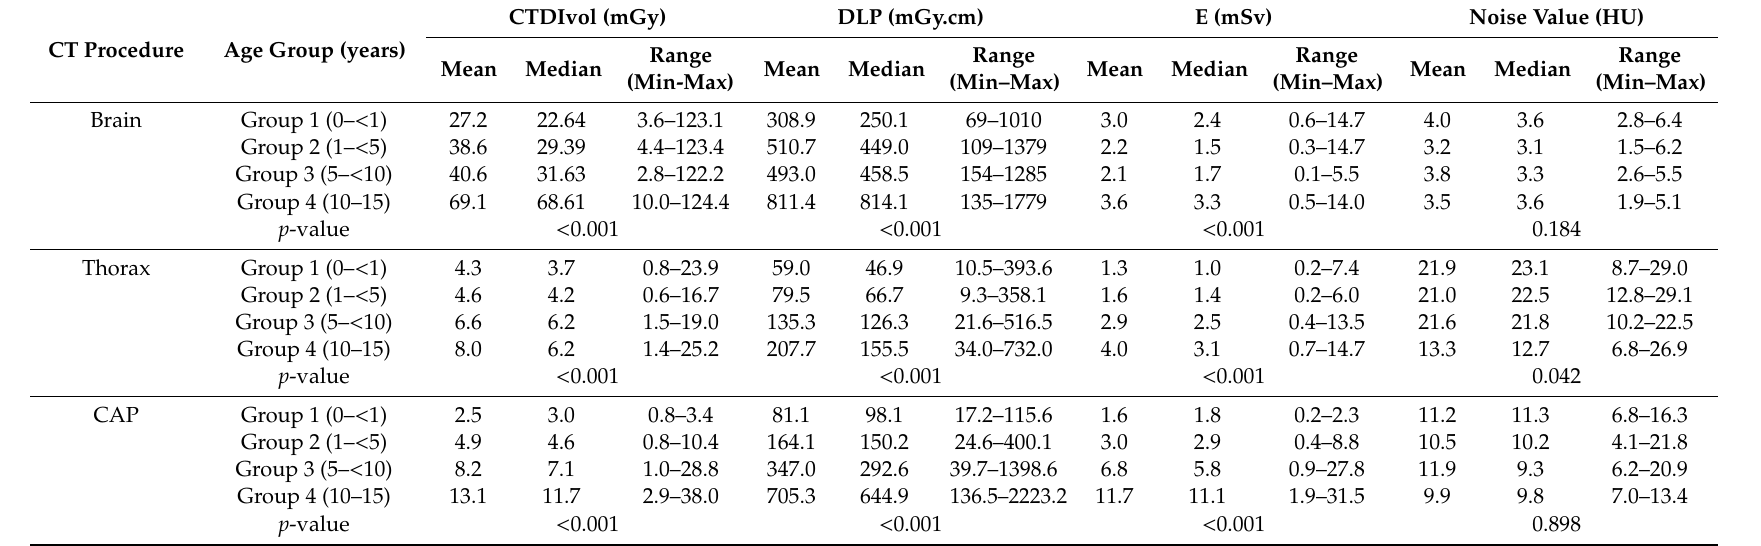
Table 3. Summary of radiation dose and noise